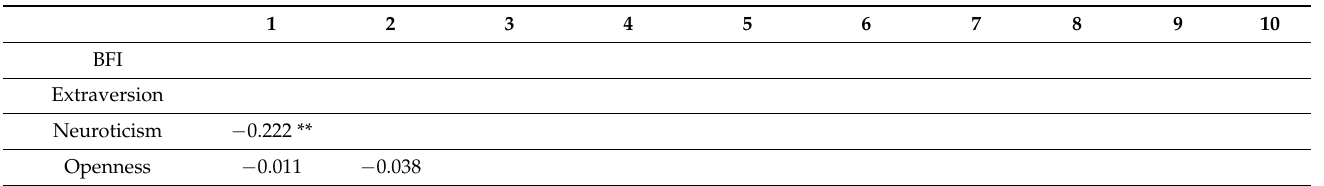
Table 1. Bivariate correlations after Pearson with ISR, BFI-10, and MPPUS (total